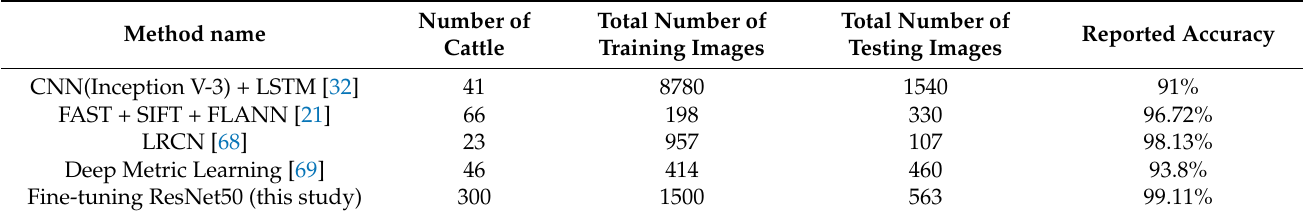
Table 5. Recent studies and their implemented models showing data size and cattle identification